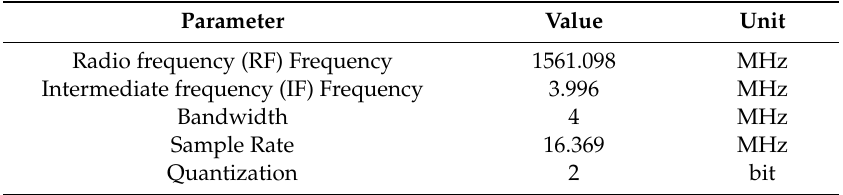
Figure 3. Scenario and experiment setup in the Yangjiang site. Table 2. Configuration of Global Navigation Satellite System (GNSS) raw signal collector.